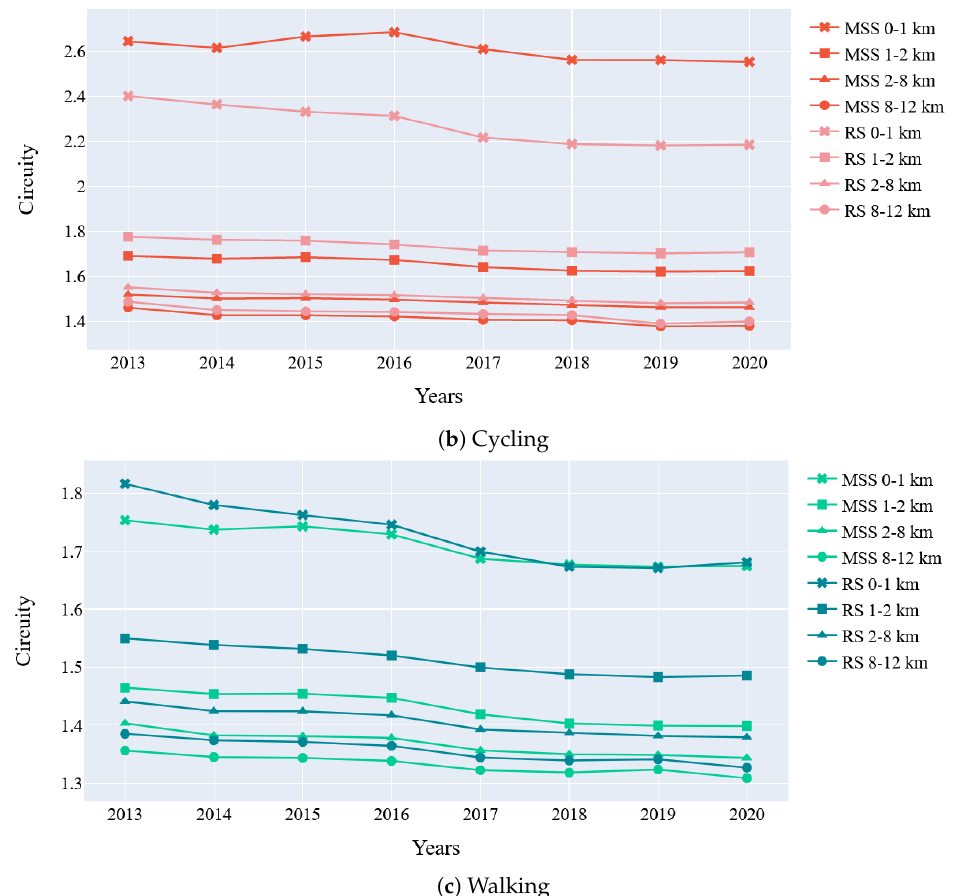
Figure 5. Average circuity for driving, cycling and walking for the period 2013–2020 for the two sampling techniques (MSS and RS) for different trips’